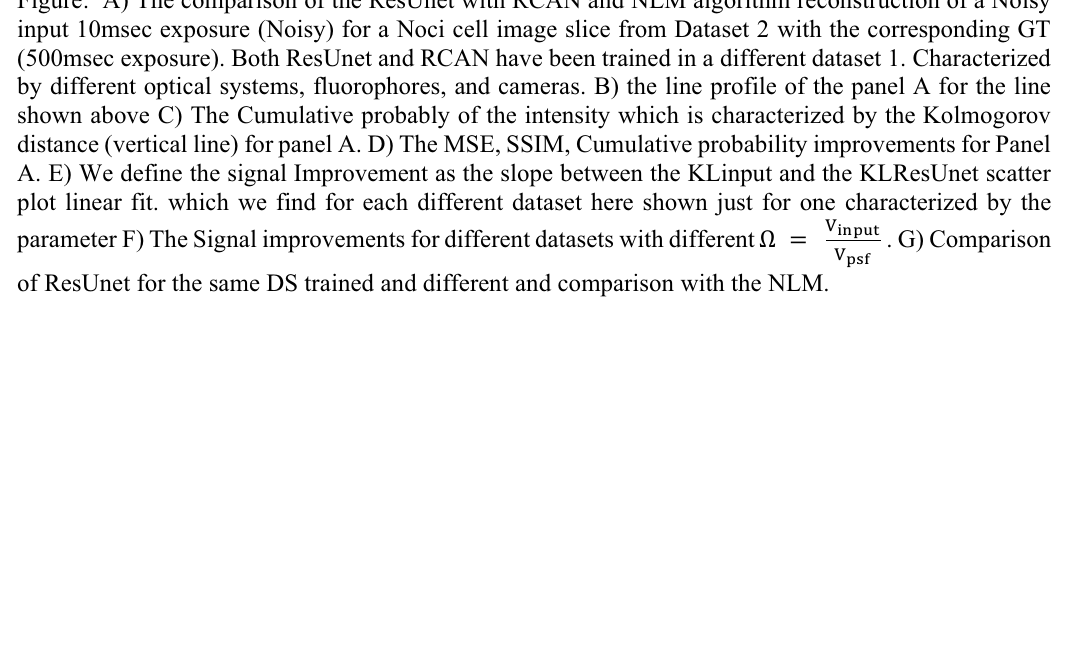
(cid:3) (cid:4)(cid:5)(cid:6)(cid:7)(cid:8) . G) Comparison (cid:3) (cid:6)(cid:9)(cid:10)